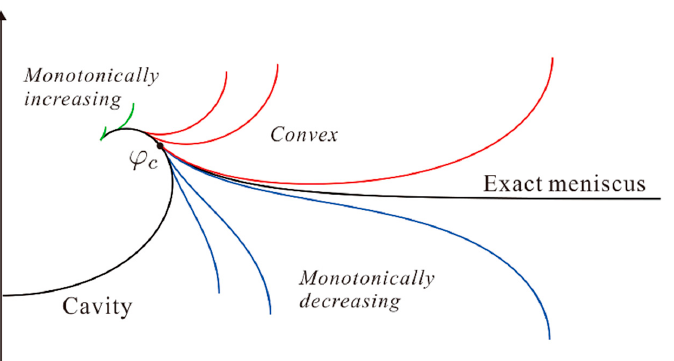
Figure 4. Three types of the meniscus shape according to the location of the guessed junction point. Here, 𝜑 (cid:3030) is the angle at the exact junction point.